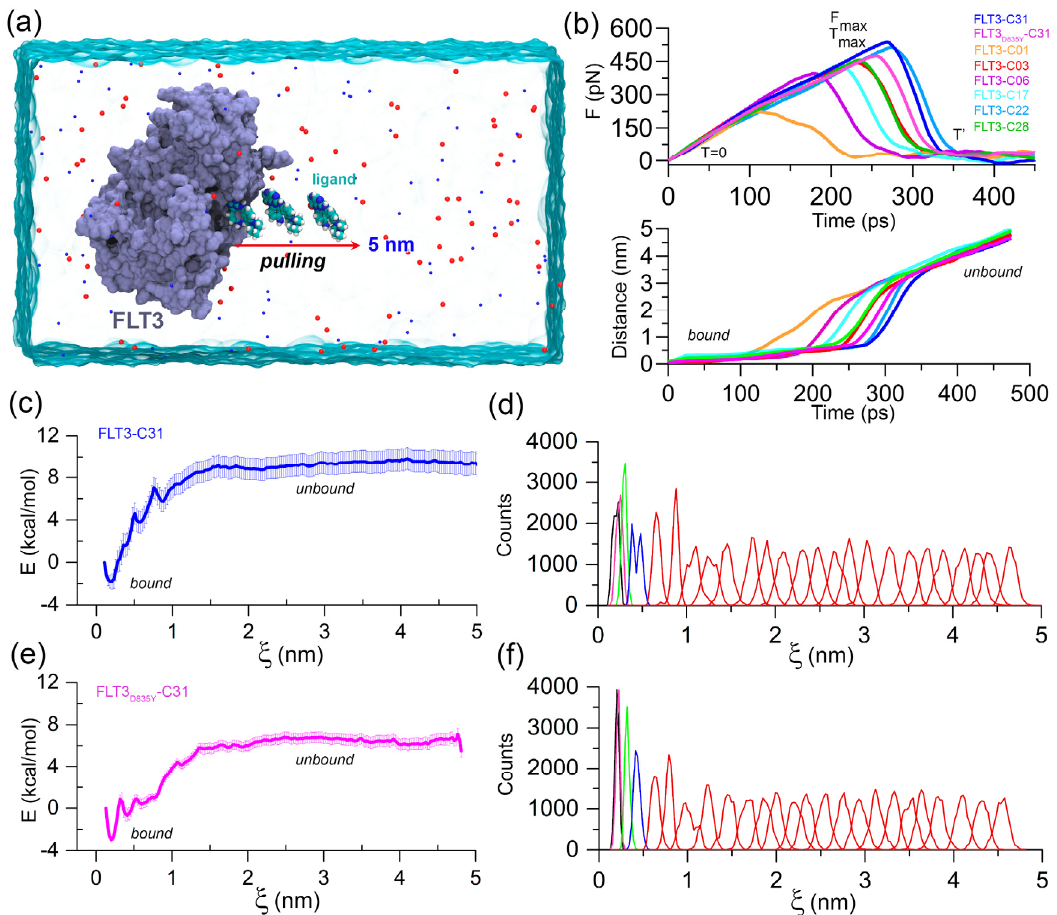
Figure 2. FPL and US simulation analysis. ( a ) Illustration of the FPL simulation setup. An external harmonic force is used to dissociate the ligand to a distance of 5 nm on the X-axis. ( b ) Graphical representation of the mean force evaluation (rupture force) and displacement of the ligands with respect to the time during the FPL runs. ( c ) PMF curve and ( d ) histogram profile of the FLT3–C31 system. ( e ) PMF curve and ( f ) histogram profile of the FLT3 D835Y –C31 system. The errors are calculated by using 1000 bootstrapping runs.